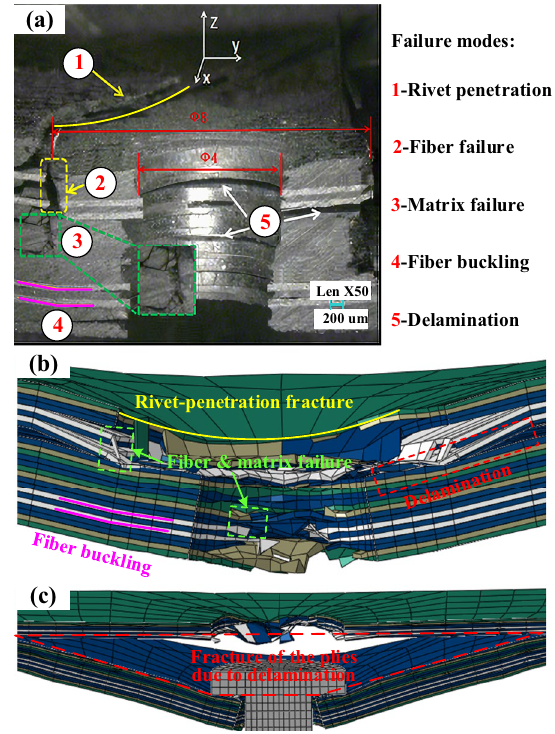
Figure 7 Damages of the experiment specimen and that of the finite element model: a damages of the experiment specimen; b damages of the FEM; c final failure status of the